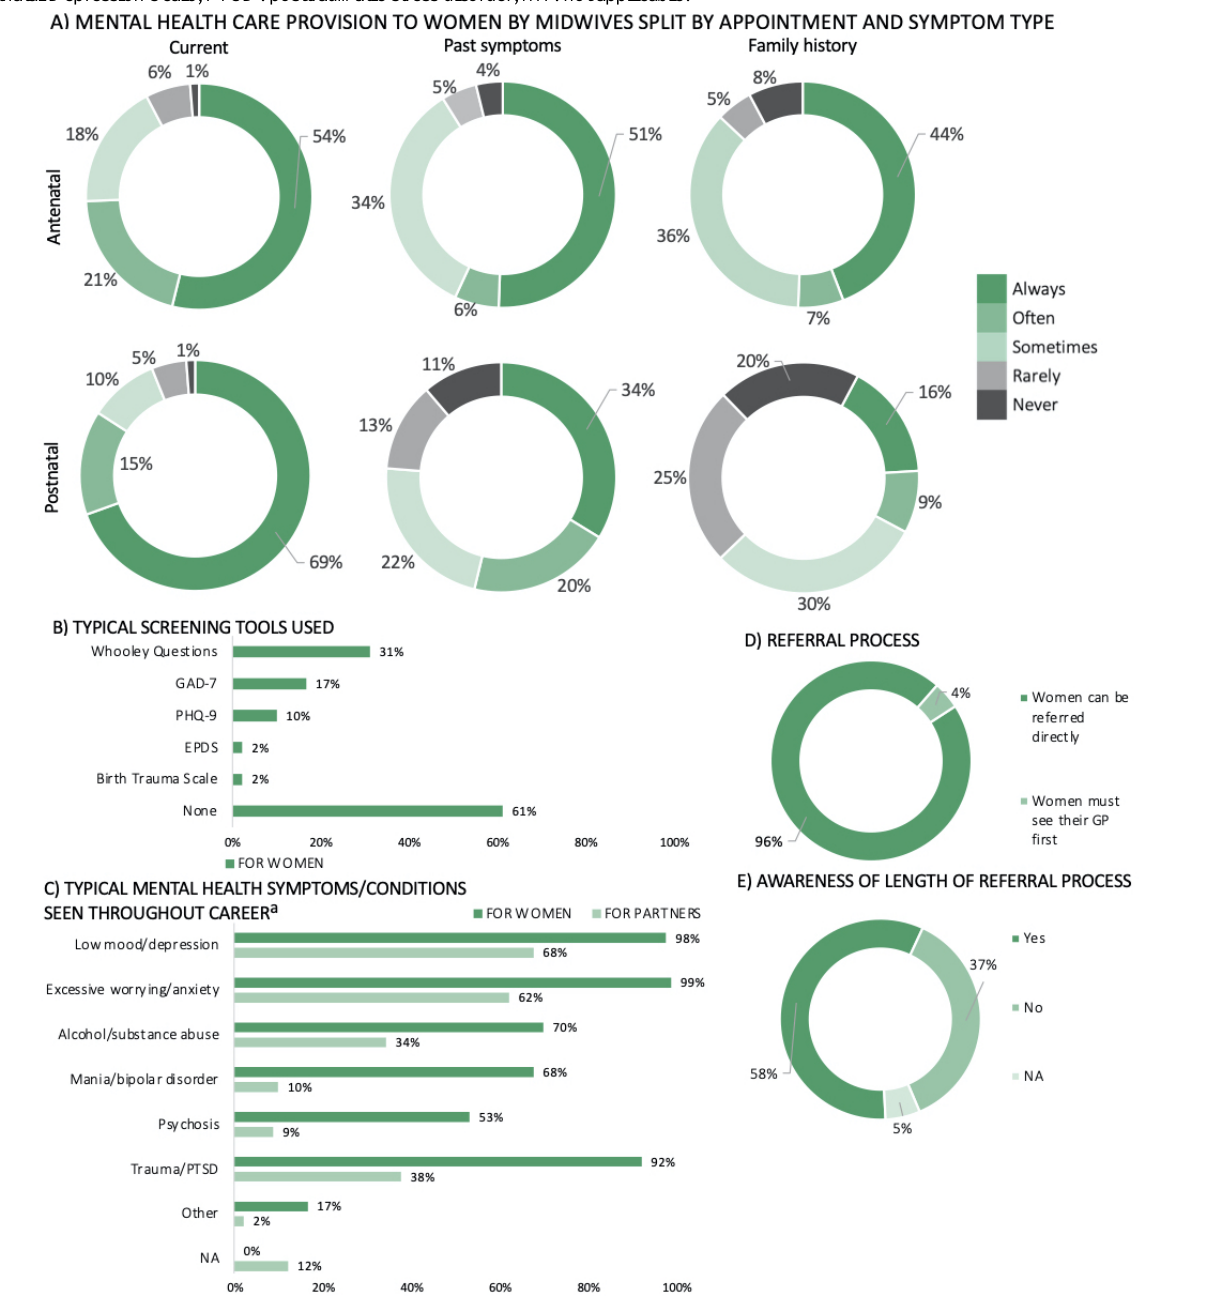
Figure 3. Midwives’ provision of perinatal mental health care, including mental health care provision provided to women split by appointment type (ie, antenatal and postnatal) and symptom type (ie, current, past, and family history) (A), typical mental health screening tools used (B), typical mental health symptoms or conditions encountered throughout their career (C), referral process (ie, whether patients can be directly referred to a mental health specialist or whether they have to see their general practitioner first (GP) (D), and awareness of the referral process (E). a: Percentages add to more than Postnatal Depression Scale, PTSD: posttraumatic stress disorder, NA: not